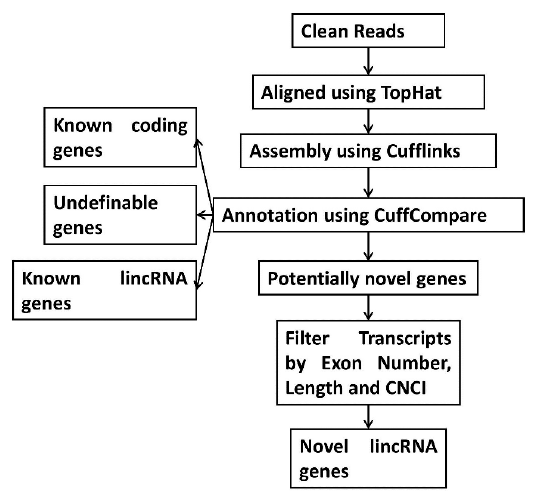
Figure A1. The pipeline used to identify putative lncRNAs.